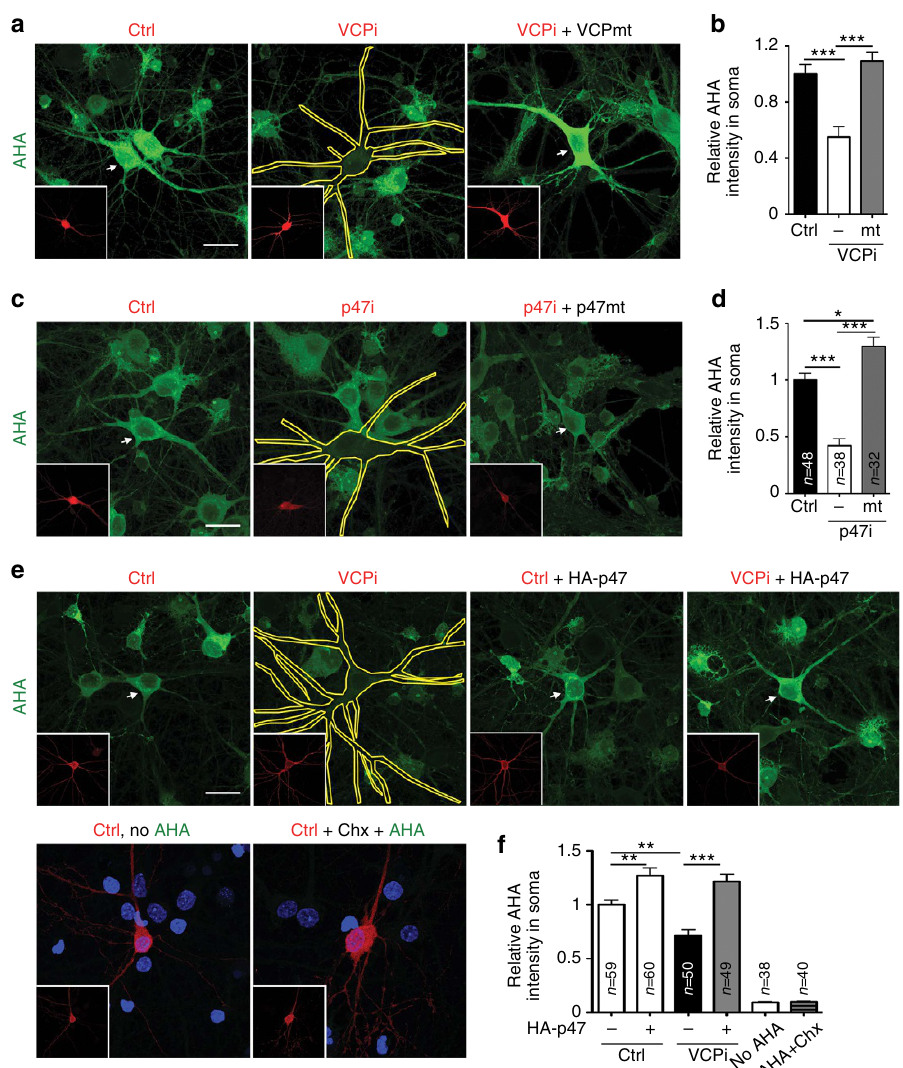
Figure 6 | Vcp and P47 knockdown impair protein synthesis. Cultured neurons were cotransfected with the indicated knockdown and expression constructs at 12 DIV and subjected to AHA labeling for 1h at 18 DIV. ( a , c , e ) Representative images of AHA labeling. The insets indicate the transfected cells, which are outlined or indicated by arrows in the original images. ( b , d , f ) The relative AHA intensity in somata. In ( e ), AHA omission or cycloheximide addition (Chx; 10 m M) was used to confirm the specificity of the AHA labeling. To indicate the presence of neurons, DAPI signals are shown in these two groups. Ctrl, non-silencing control. Scale bar: 25 m m. The sample sizes ( n ) of the examined neurons are indicated. The data from three independent experiments are presented as the mean þ s.e.m. (error bars). * P o 0.05; ** P o 0.01; *** P o 0.001. One-way ANOVA ( b , d ), two-way ANOVA ( f